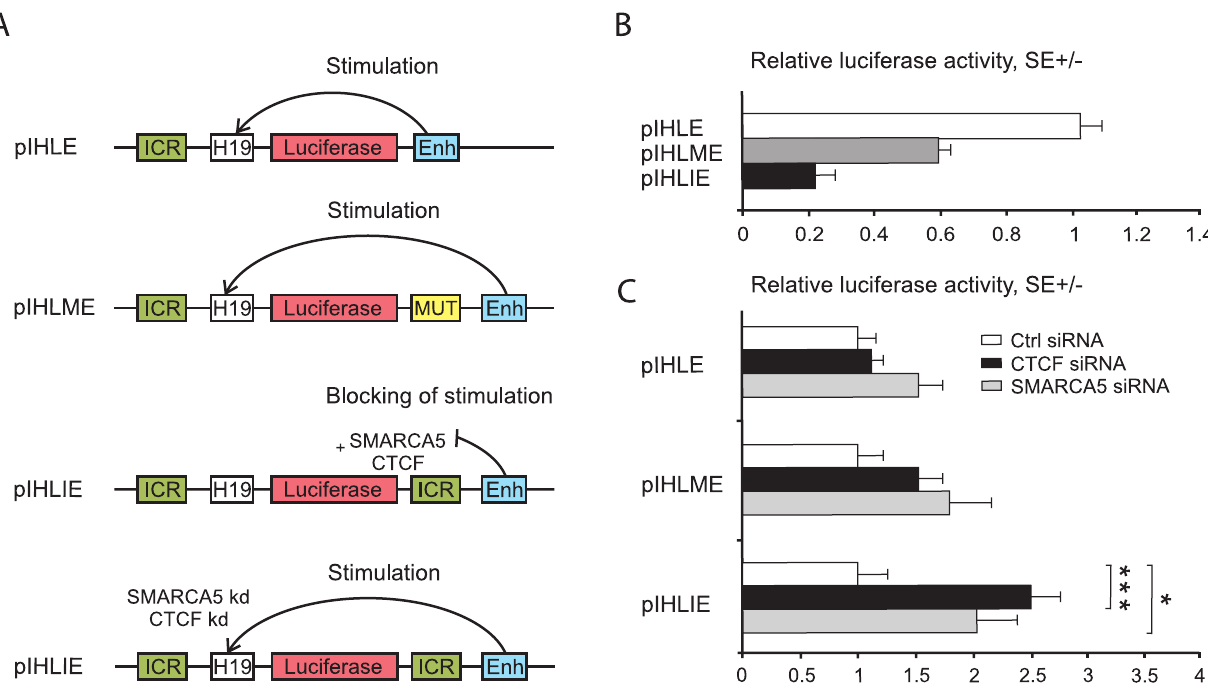
Figure 2. SMARCA5 cooperates with CTCF on enhancer-blocking activity of H19 promoter. A: schematic representation of the reporter constructs pIHLE (without ICR), pIHLME (with mutated CTCF bindng site at the ICR) and pIHLIE (with ICR that can bind CTCF). ICR, insulator of H19 gene; H19, promoter of H19 gene; luciferase, luciferase gene; Enh, SV40 enhancer; MUT, insulator with mutated CTCF binding sites; kd, protein knock- down. B: Luciferase activity of reporter constructs in HeLa cells. Luciferase acitivity was normalized on Renilla, the pIHLE was set equal to 1. C: HeLa cells depleted for either CTCF or SMARCA5 (using siRNAs) were analyzed for luciferase activity of reporters. Luciferase activity was normalized on non- specific siRNA (Ctrl siRNA) that was set equal to 1, error bars indicate standard errors (SE), t-test (p , 0.05 indicated by star).